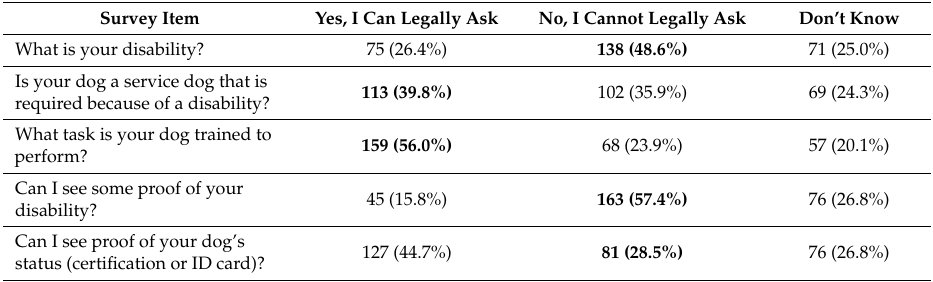
Table 4. Knowledge of legal enquiries pertaining to assistance dogs. Participants were asked to indicate which of the following questions they are legally permitted to ask in determining if an animal qualifies as an assistance dog.